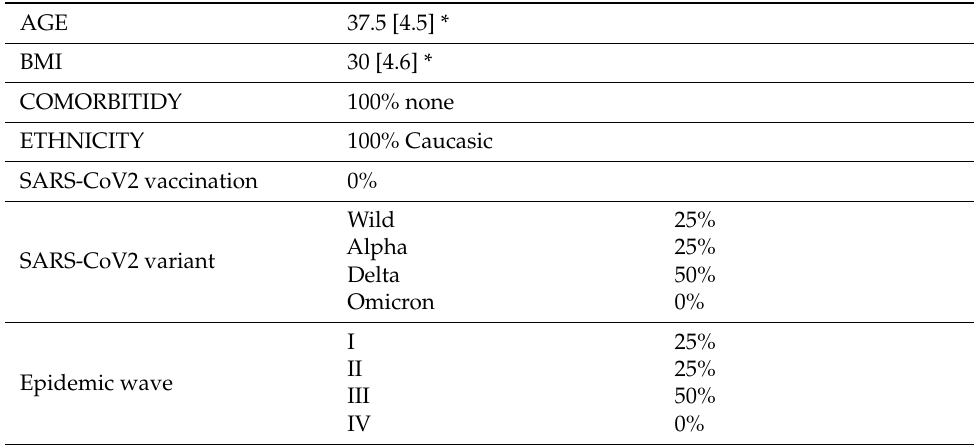
Table 2. Main characteristics of the severe-critical cases (N